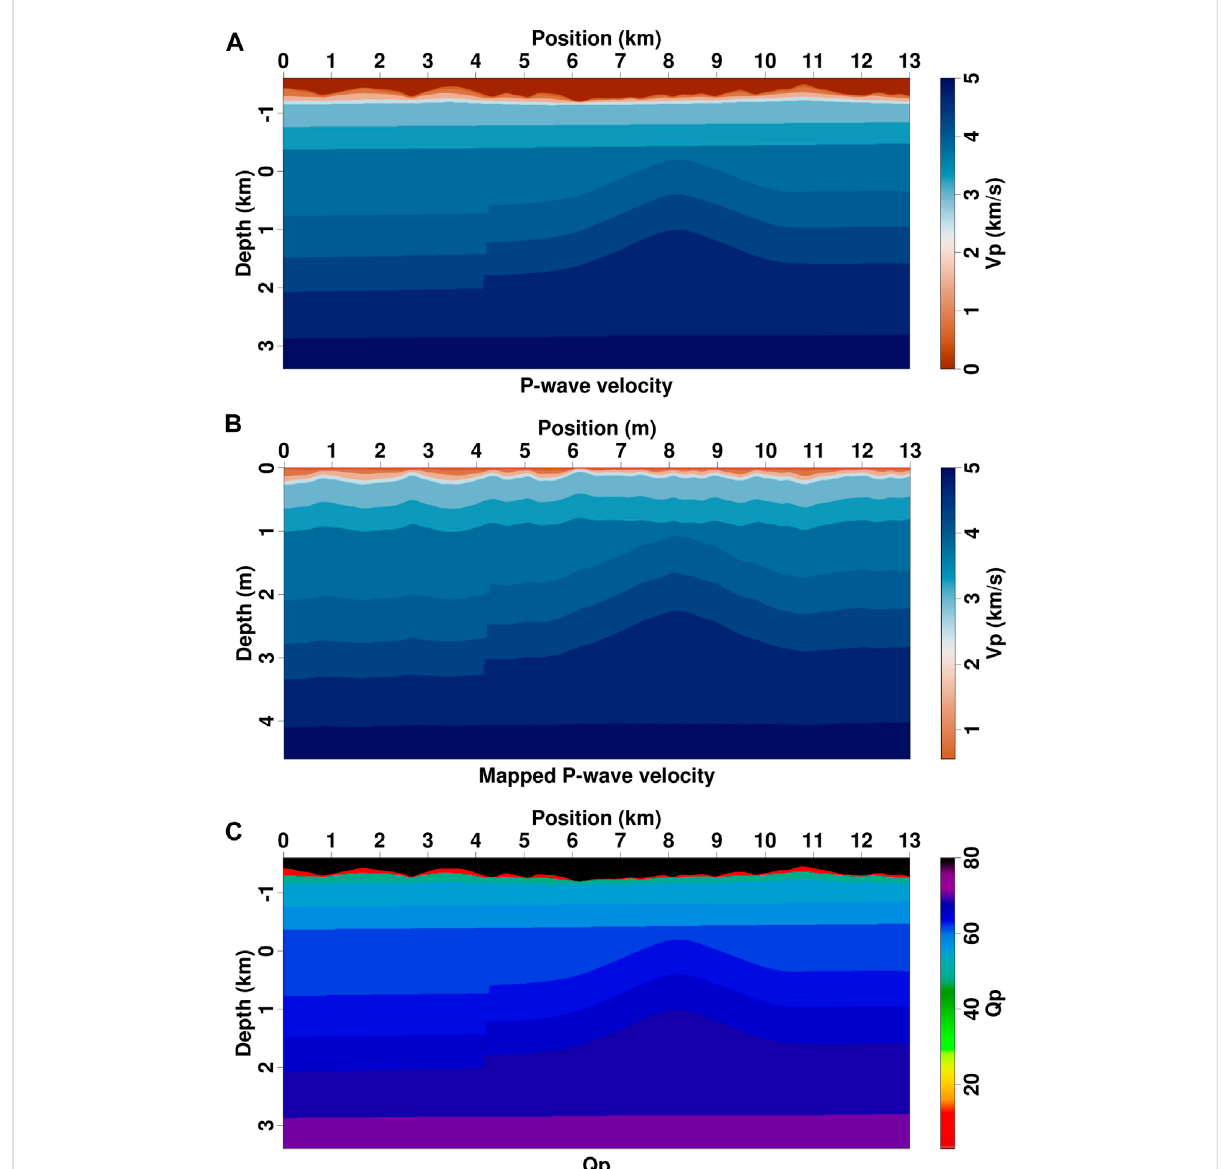
computational domain by vertical stretching according to Eq. 8, in which velocity, density and Q parameters onto the computational grids are calculated using a linear interpolation method. Next, the viscoacoustic wave equation 11 is solved in a regularly-sampled computational domain using any available numerical solvers. Finally, the wave fi elds in the real physical space are reconstructed by mapping the extrapolated wave fi elds back with the same interpolation algorithm used in the second step.